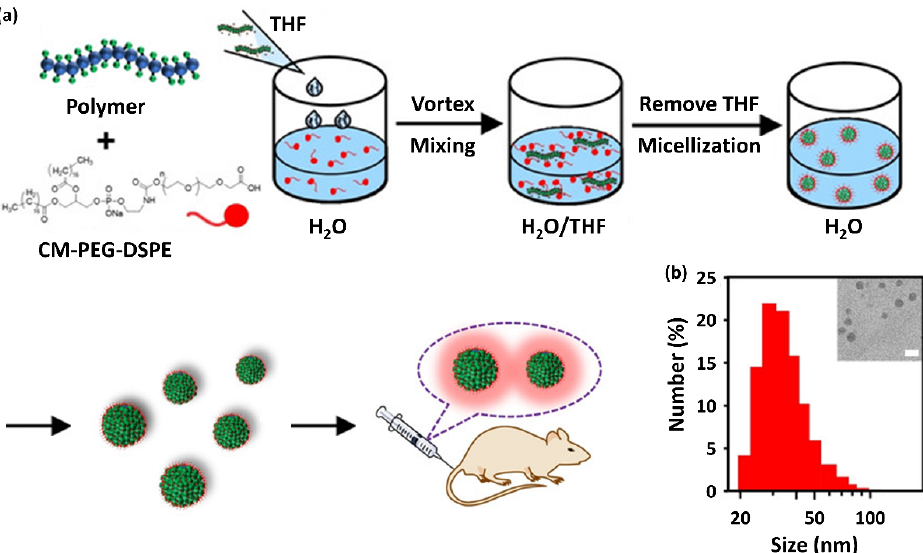
Figure 18. ( a ) Schematic showing the preparation of lipid-protected polymer dots (Pdots) for in vivo bioimaging. ( b ) Representative hydrodynamic sizes of probe 24 Pdots measured by dynamic light scattering. The upper-right inset represents the corresponding transmission electron microscopy image with a scale bar of 50 nm. Reprinted with permission from Ref. [8]. Copyright 2020, John Wiley and Sons.